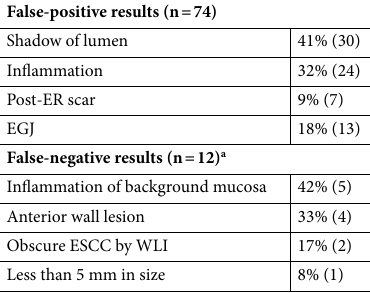
Table 4. Details of the false-positive and false-negative lesions. ER: endoscopic resection, EGJ: esophagogastric junction, ESCC: esophageal squamous cell carcinoma, WLI: white light imaging. a 12 lesions in 11